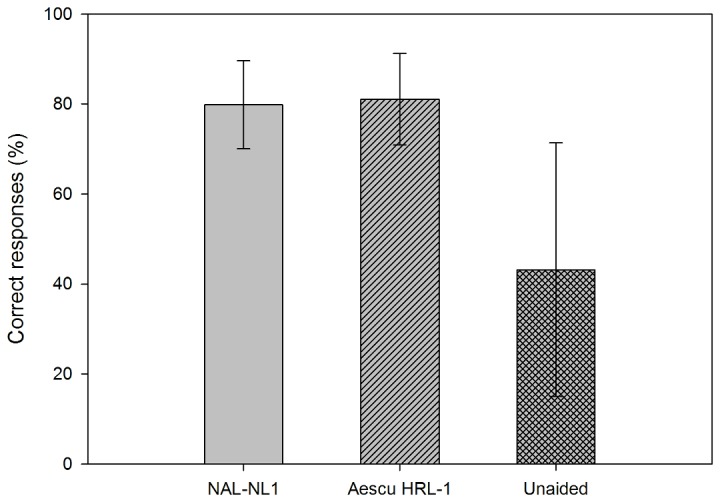
Percentages of correct MMRT responses among the 15 subjects at a moderate speech level.Data show mean and standard deviation values.